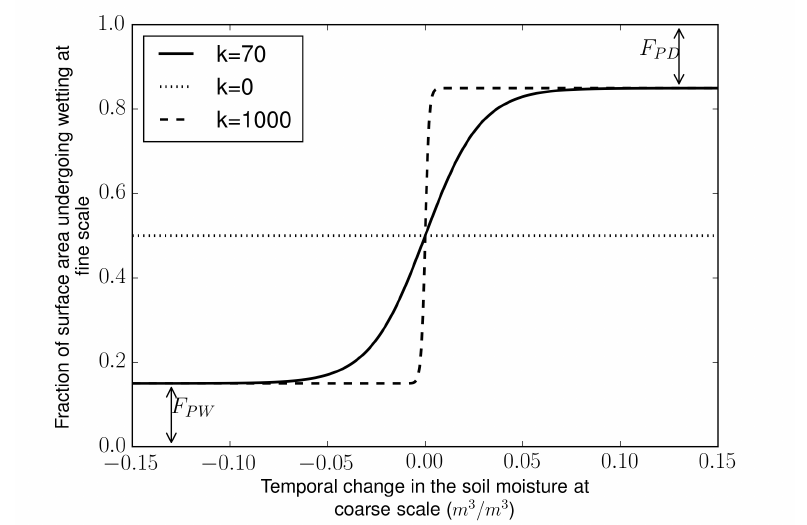
Figure 4. Conceptual relationship between the fraction of surface undergoing wetting at fine scale ( F wet ) and the temporal change in the coarse scale soil moisture ( SM t values (0, 70,